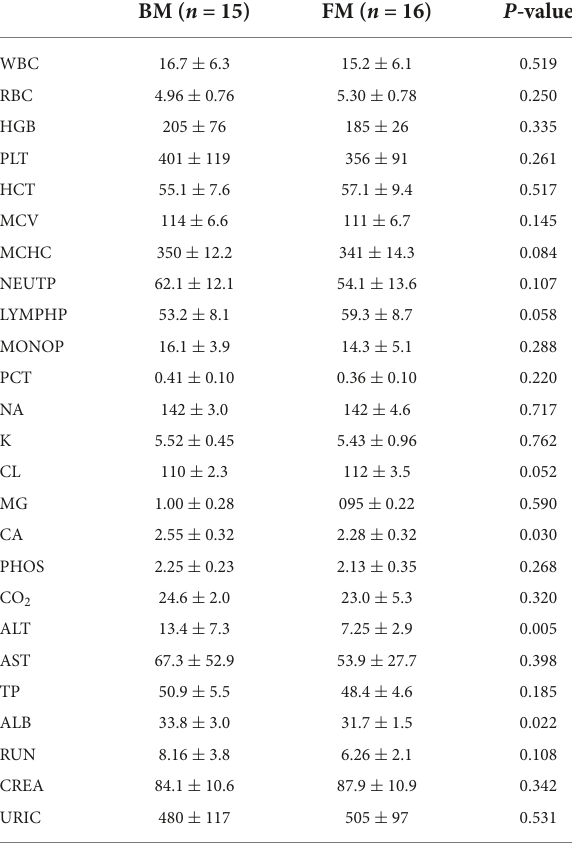
TABLE 3 Secondary clinical outcomes in premature infants.